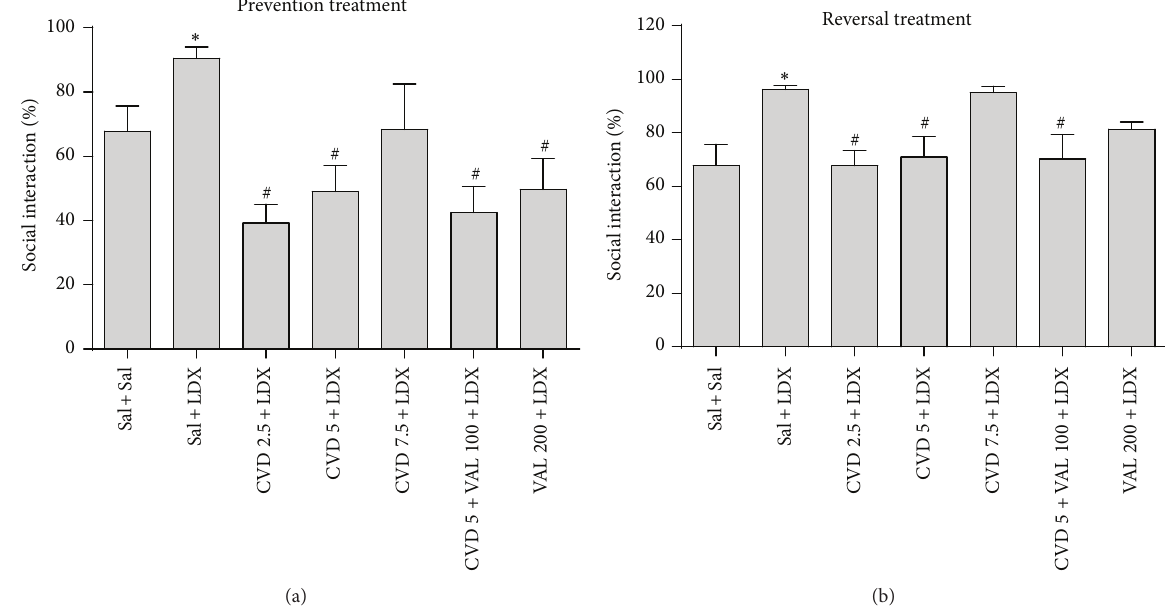
Figure 3: Percent of social interaction in animals submitted to the prevention (a) and reversal (b) treatments. Data were analyzed by one-way ANOVA followed by Student-Newman-Keuls post hoc test. Values are expressed as mean ± SEM (6–8 animals/group). ∗ 𝑃 < 0.05 versus Sal + Sal; # 𝑃 < 0.05 versus Sal + LDX or LDX + LDX. CVD: carvedilol; LDX: lisdexamfetamine; Sal: saline; VAL: